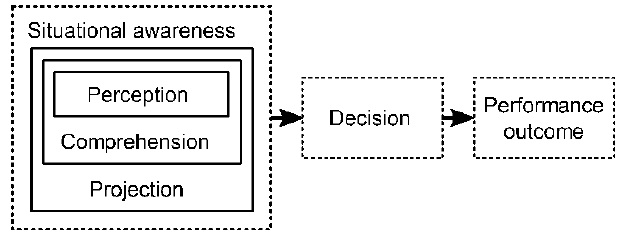
Figure 1. Endsley’s model of situational